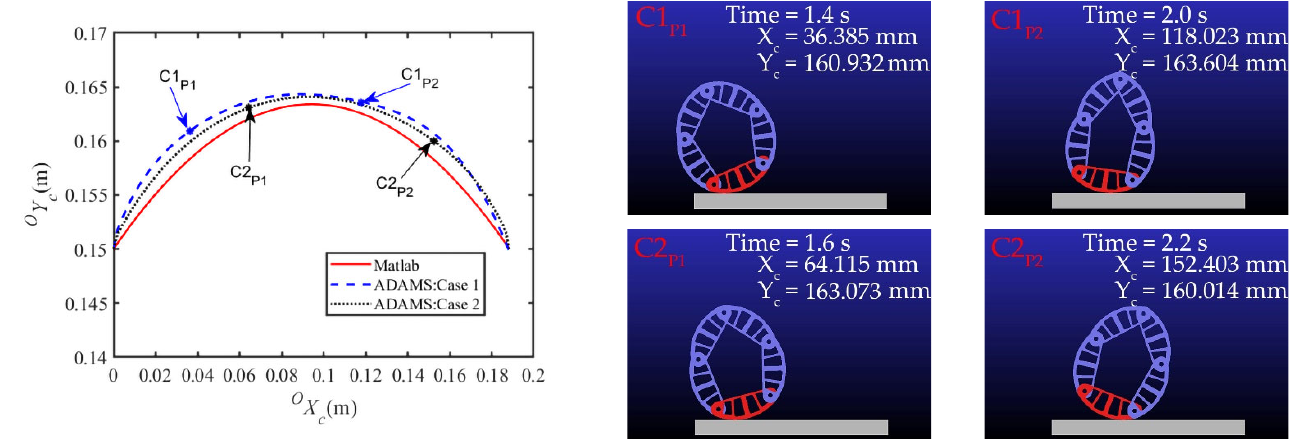
Figure 15. Theoretical and simulated trajectories of the CoM at h = 0.177 m.